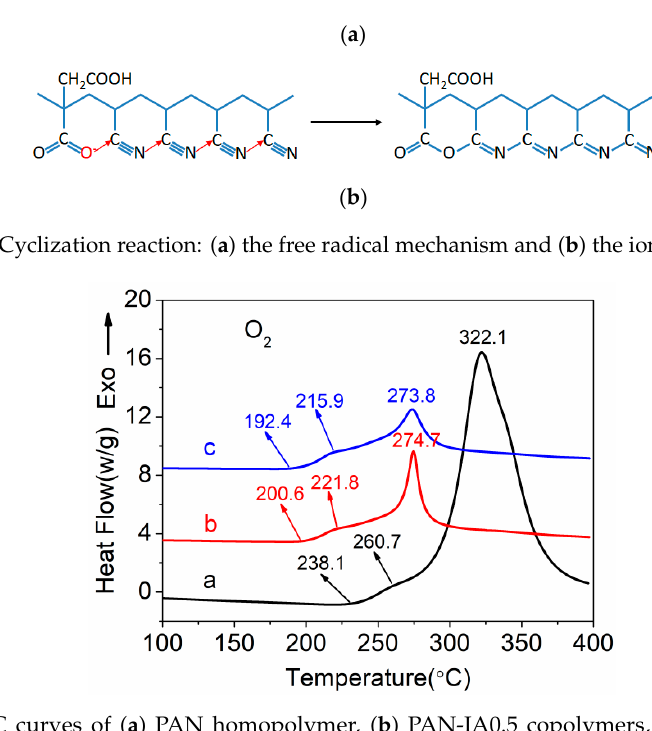
Table 4. DSC parameters of PAN homopolymer and PAN-IA copolymers in an air atmosphere.